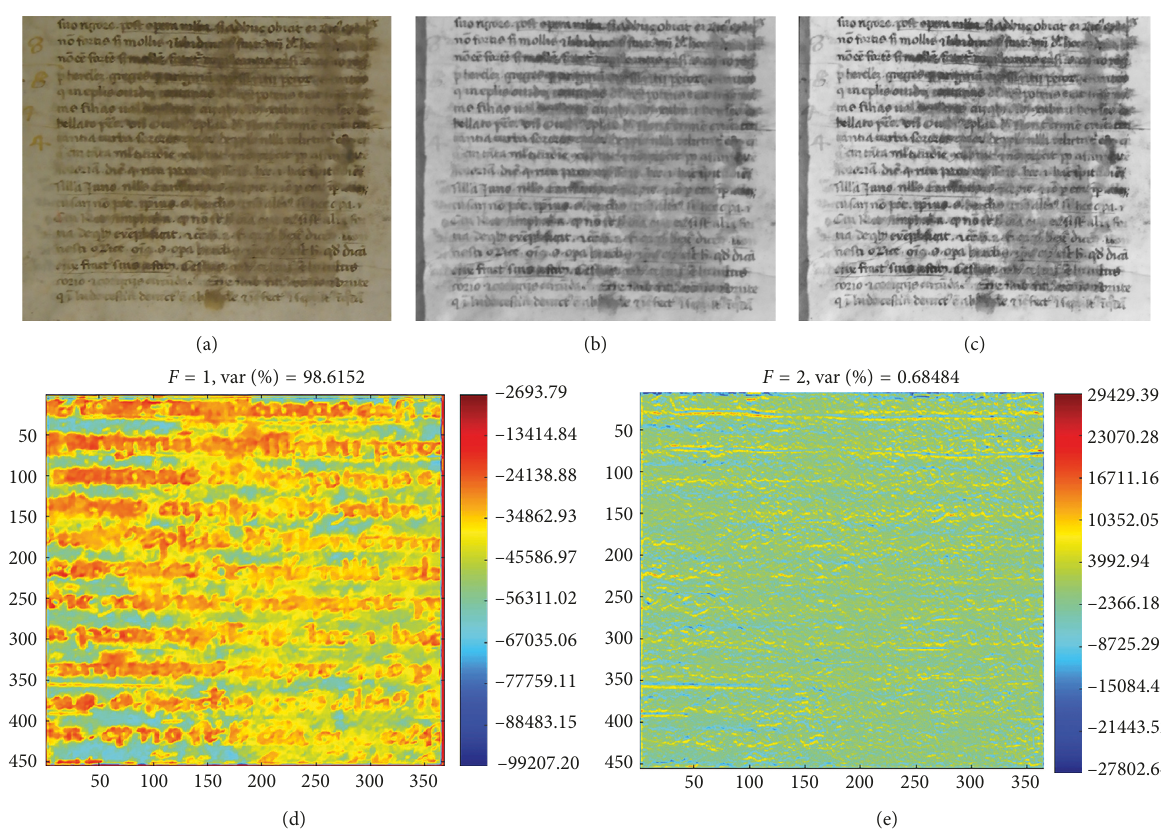
Figure 9: Photography (a) and visible images taken at 600nm (b) and 680nm (c) of details of Parch. 37. (d, e) Image processing results by PCA: score image of PC1 (variance 98.62%) and score image of PC2 (variance